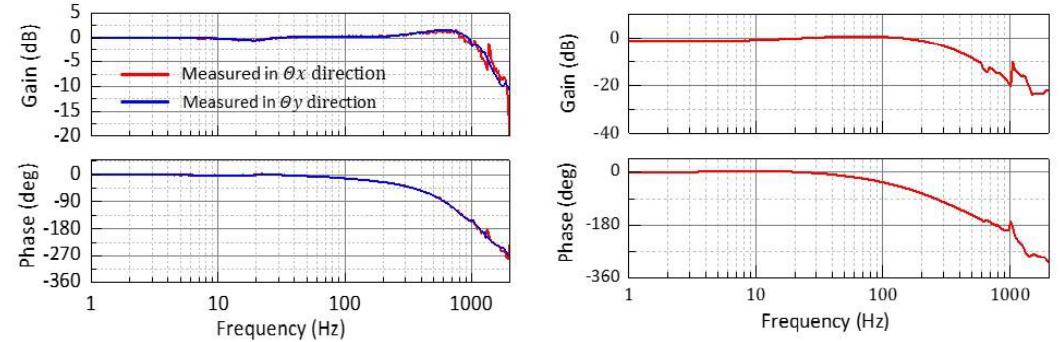
Figure 12. Reference characteristics of the FSM with the magnetic suspension; ( a ) Bode plot for the θ x and θ y directions; ( b ) Bode plot for the Z direction.